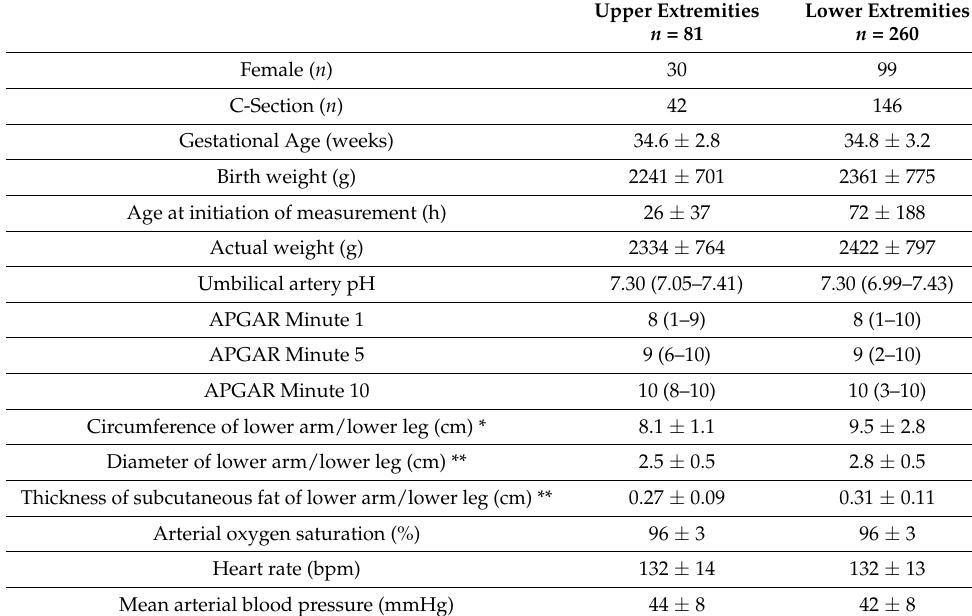
Table 1. Demographic, clinical and monitoring data of included neonates. Data are presented as mean ± SD or median (range). (* Largest circumference of the extremity was measured with a measuring tape below the sensor placement; ** Diameter and thickness of subcutaneous fat were measured at the largest circumference of the extremity using